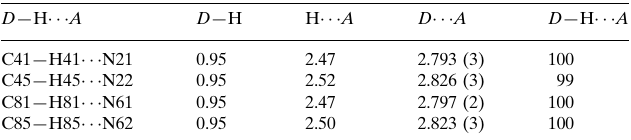
Hydrogen-bond geometry (A˚ , (cid:1)